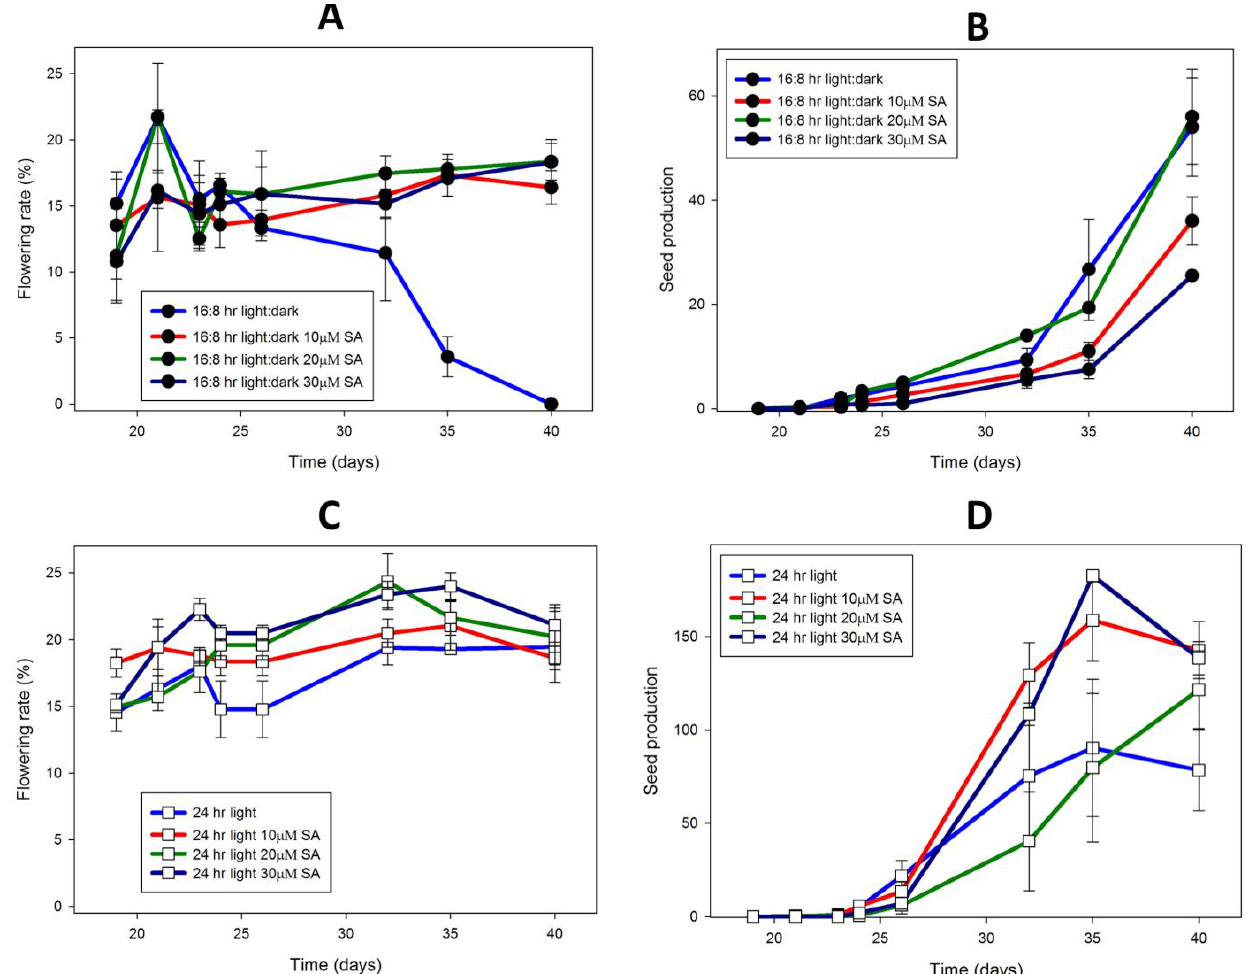
Figure 9. L. gibba G3 DWC114 flowering is not affected by daylength but requires SA, whereas seed production is greatly increased under constant light, and is dependent on SA concentration. Flowering rate is described as the percent of flowering fronds per 100 fronds. Seed production was measured as the number of seed per flask. Flowering ( A ) and seed production ( B ) In LD with various concentrations of SA. Flowering ( C ) and seed production ( D ) under CL with various concentrations of SA. Data are the average ± SEM ( n = 3).